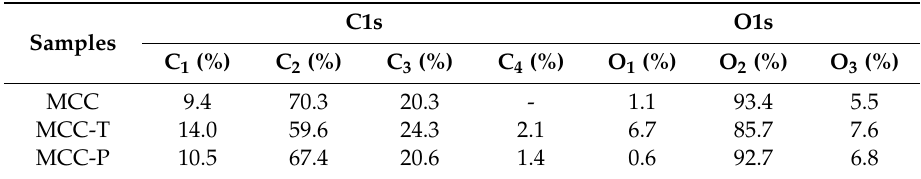
Figure 6. High resolution XPS spectra and deconvolution in the C1s and O1s regions. Table 2. The relative atomic concentrations of differently bound carbon and oxygen atoms as determined from high resolution XPS spectra .